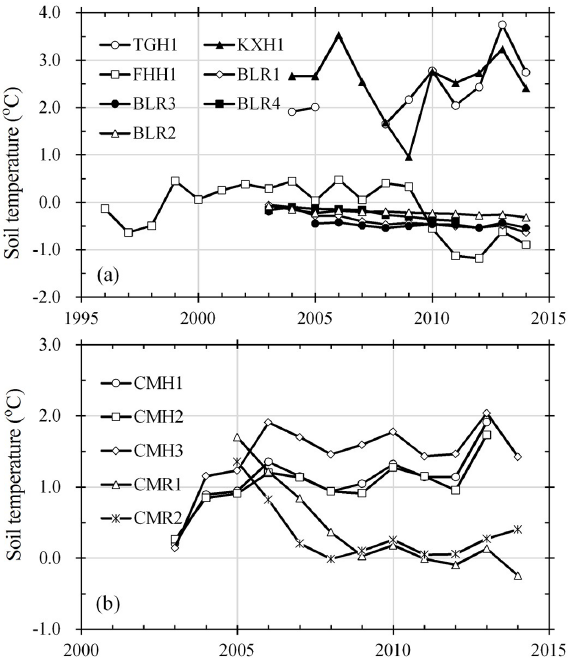
Figure 5. Mean annual soil temperature at 0.5m depth beneath em- bankment base in alpine meadow (a) and alpine steppe (b) .